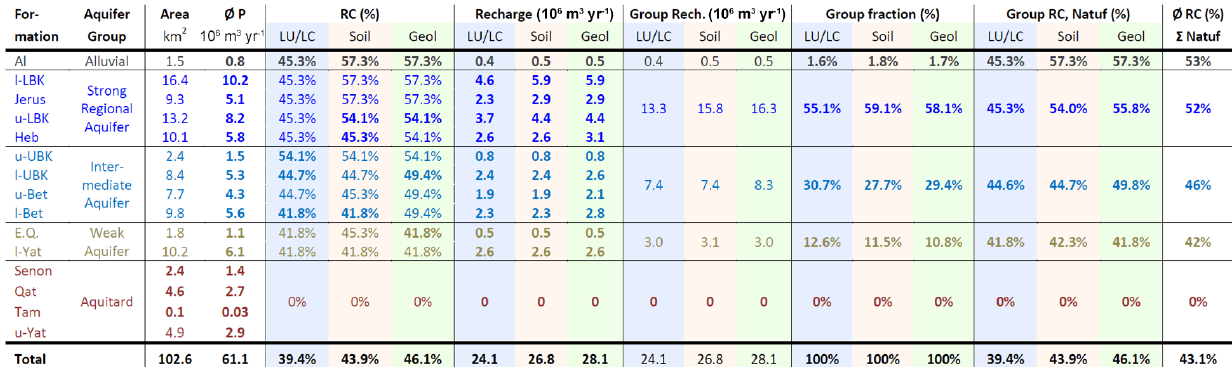
Table A1. Recharge of all formations and aquifer groups in all of Wadi Natuf, detailed by groups of physical features (as coefficients and annual recharge